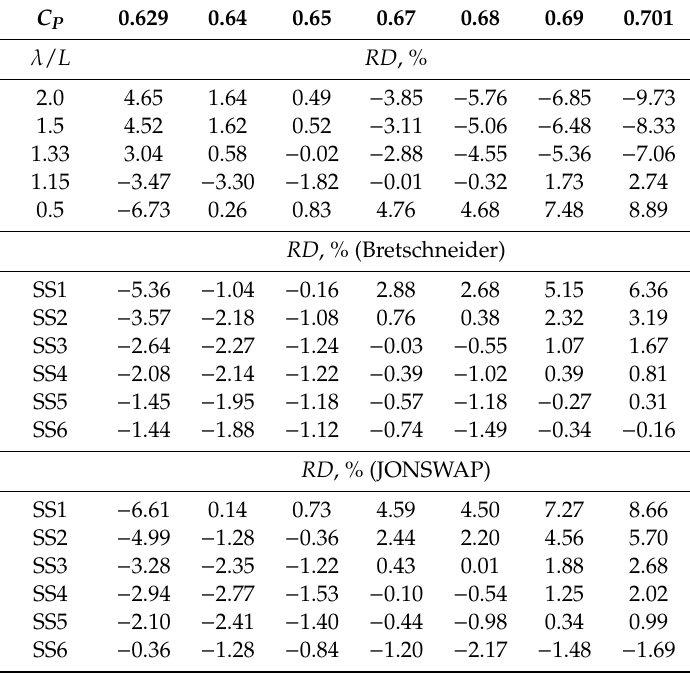
Table 5. Influence of the prismatic coe ffi cient on added resistance in regular and irregular waves. JONSWAP, Joint North Sea Wave